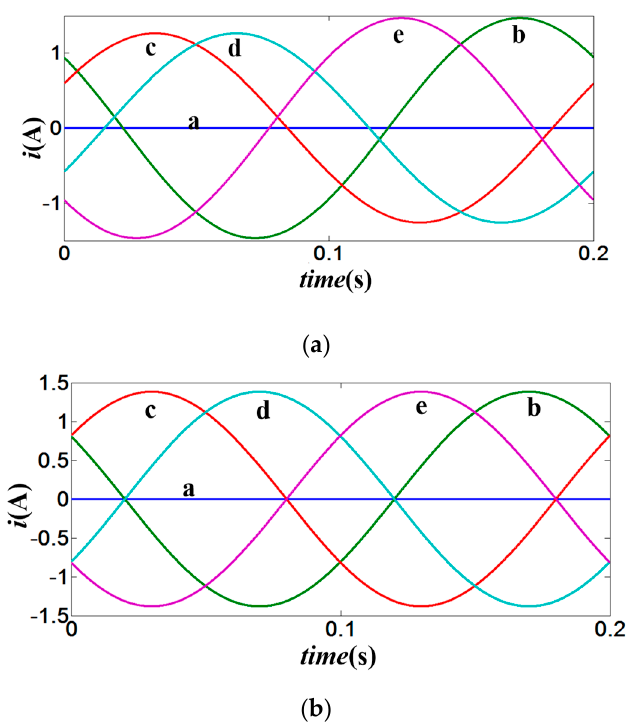
Figure 5. Fault-tolerant current based on single phase fault-tolerant control law: ( a ) MCL; ( b ) MTO.